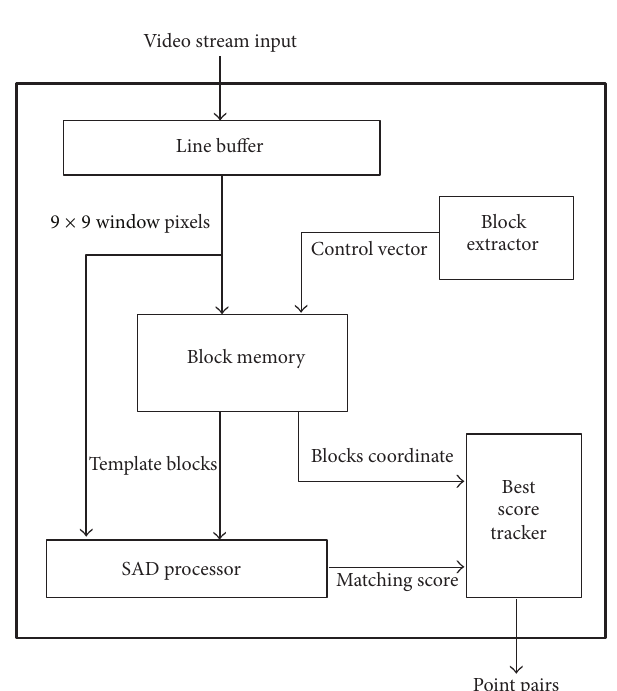
Figure7:Stream-orientedhardwarearchitectureofblockmatching.